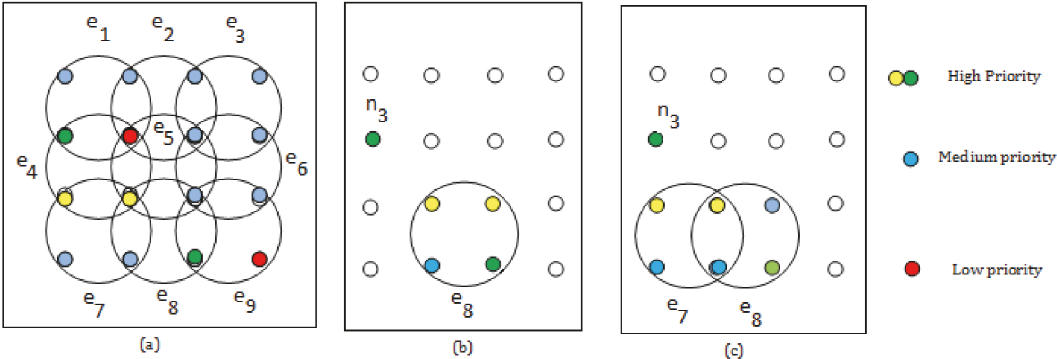
Figure 1: Intuitionistic fuzzy hypergraphs ( a) H, (b) X, and (c)